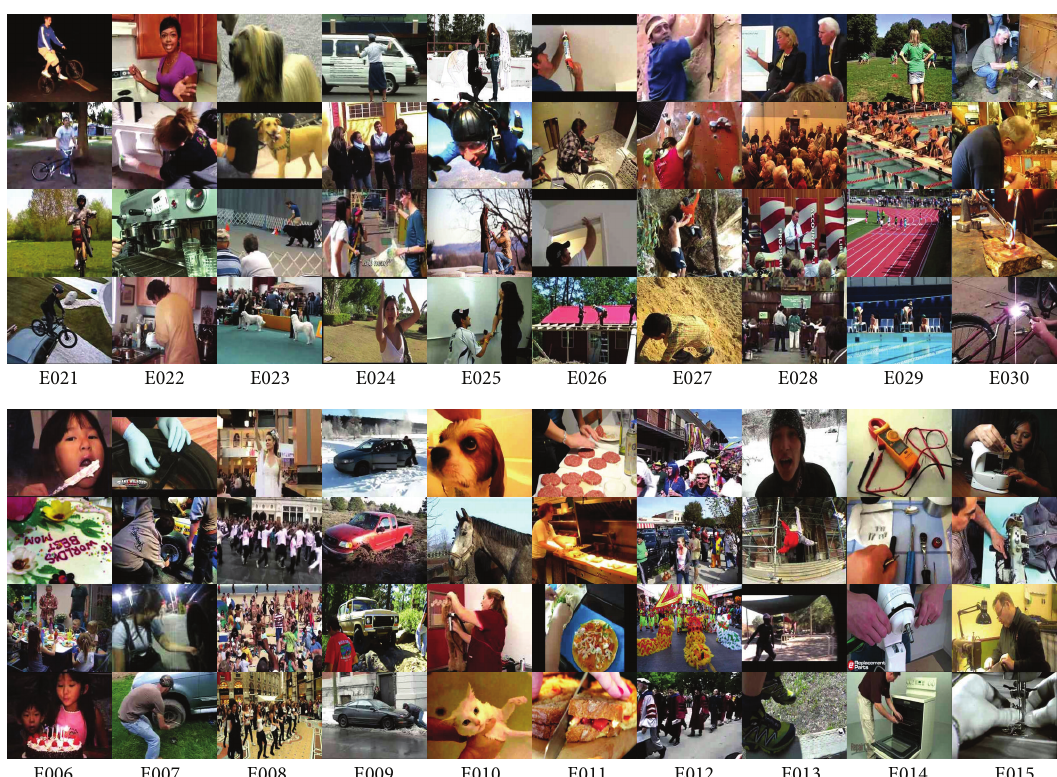
Figure 3: Sample frames of 20 events in TRECVID MED 2012